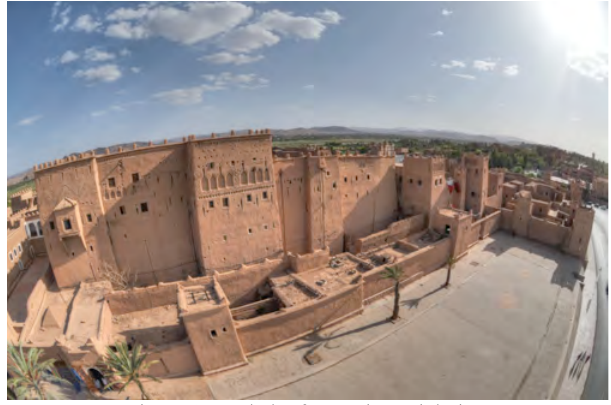
Figure 1: Kasbah of Taourirt aerial